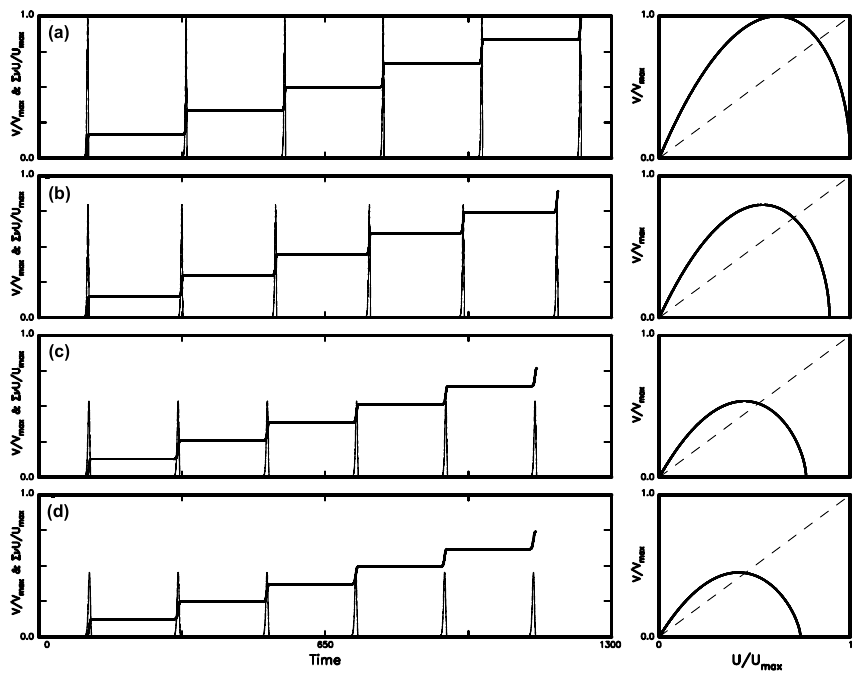
Figure 6. The time variations in V/V max (thin solid line) and cumulative slip (cid:54)U/U max (solid line) and the phase portrait of V/V max versus U/U max (solid line) for four values of η : (a) for η = 0.2; (b) for η = 0.4; (c) for η = 0.8; and (d) for η = 1.0 when U c = 0.5.